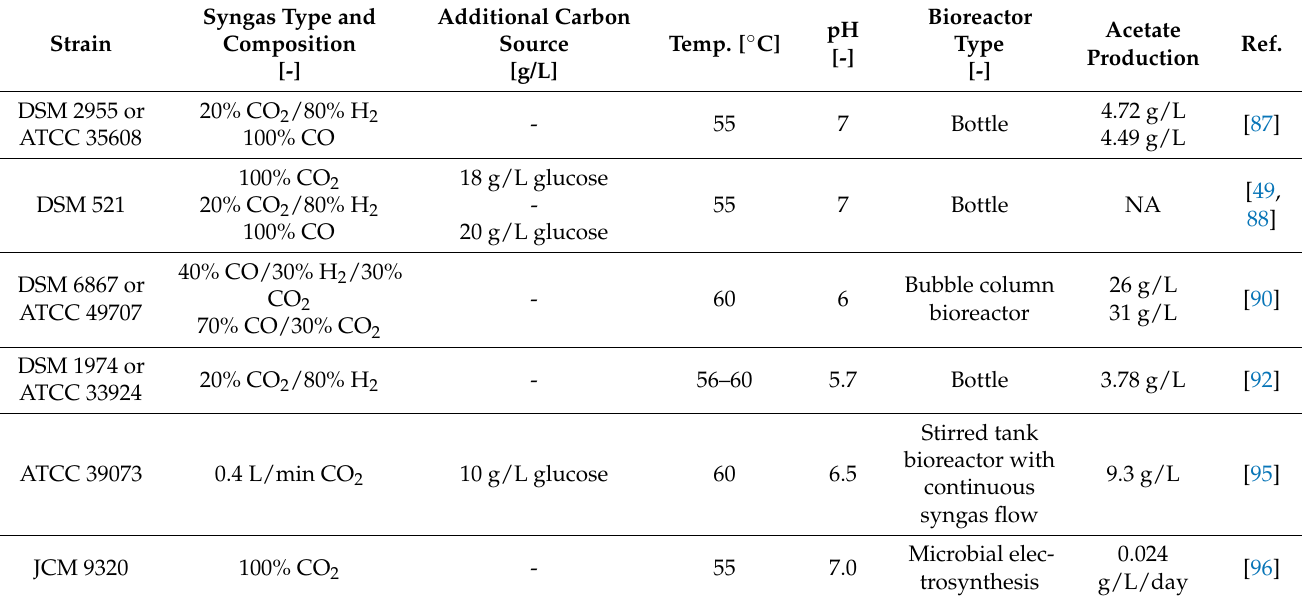
Table 3. Comparison of acetate production by several strains of M thermoacetica , their syngas fermen- tation conditions, and bioreactor